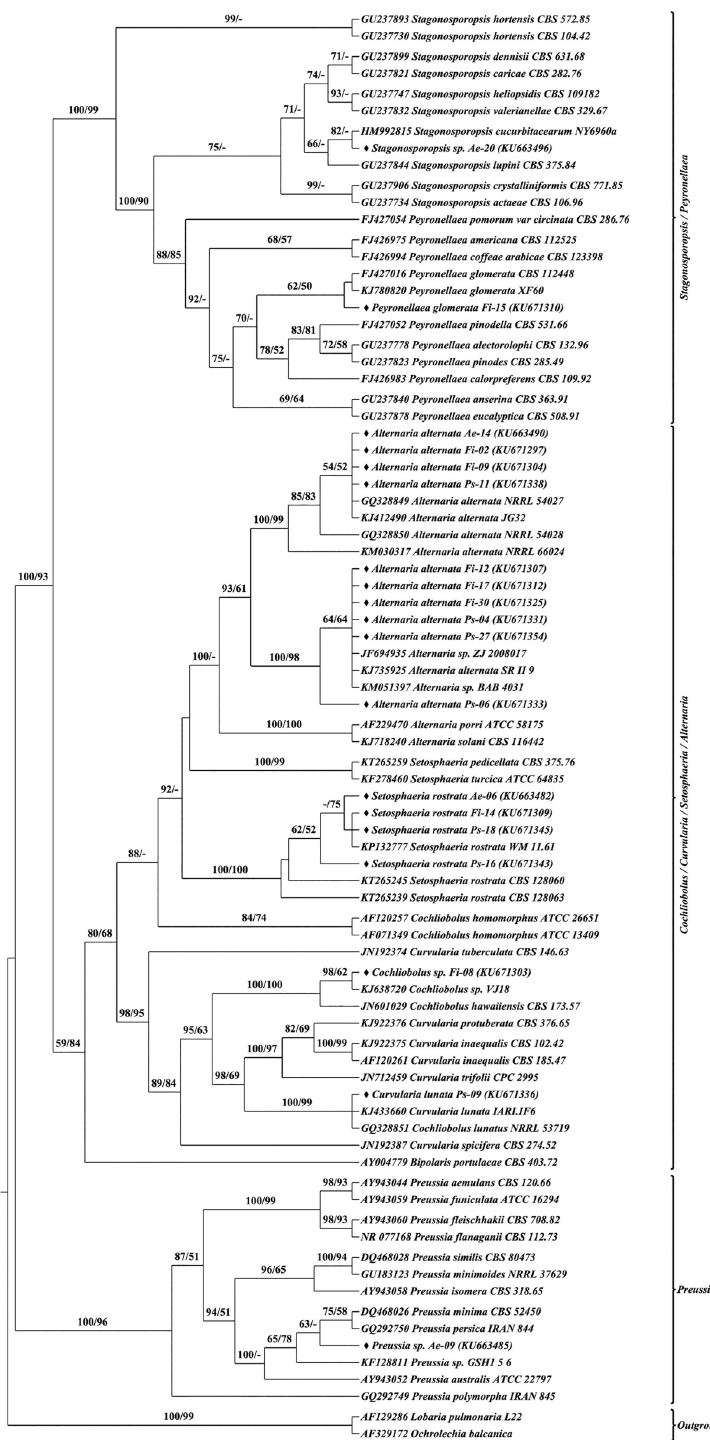
Fig 10. Internal transcribed spacer 2 sequence–secondary structure based phylogenetic tree of Pleosporales query and reference sequences. The query sequences are represented by the symbol “ ♦ ”. Bootstrap (BP) values � 50 were represented in the tree. Maximum Likelihood tree was presented with branch support values as BP of ML tree / BP of NJ tree.